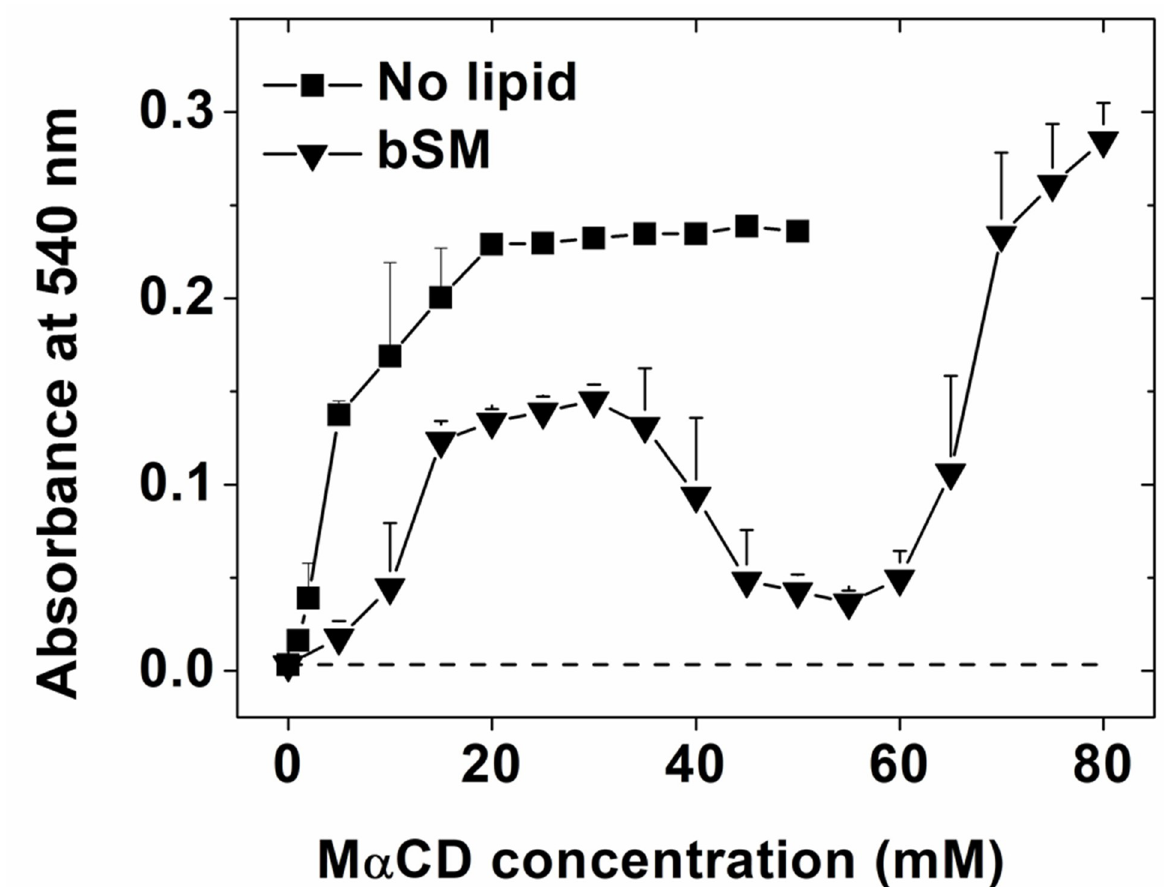
Fig 1. M α CD concentration and lipid affect rabbit RBC lysis. Absorbance at 540 nm detects hemoglobin released after cell lysis. Lysis measured in the presence of M α CD (squares) or a mixture of 1.5 mM bSM with M α CD (triangles). The dotted line represents untreated RBC control. Mean and standard deviation from three experiments is